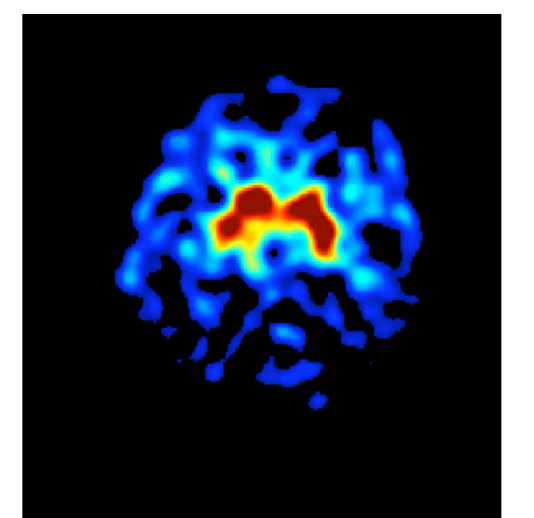
Figure 2. Human PET-FMT image.